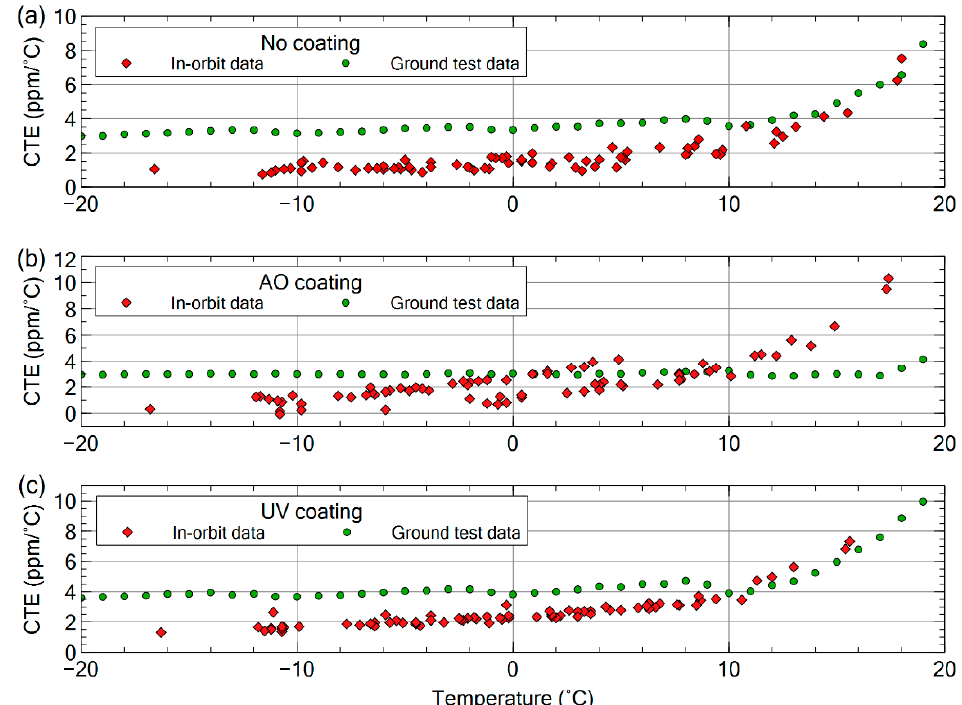
Figure 16. Comparison of CTE values between ground validation test data and in-orbit data for all MM samples. ( a ) Sample with no coating; ( b ) sample with AO coating; ( c ) sample with UV coating. Table 4. Comparison of the average change in CTE with temperature for ground and in-orbit data.